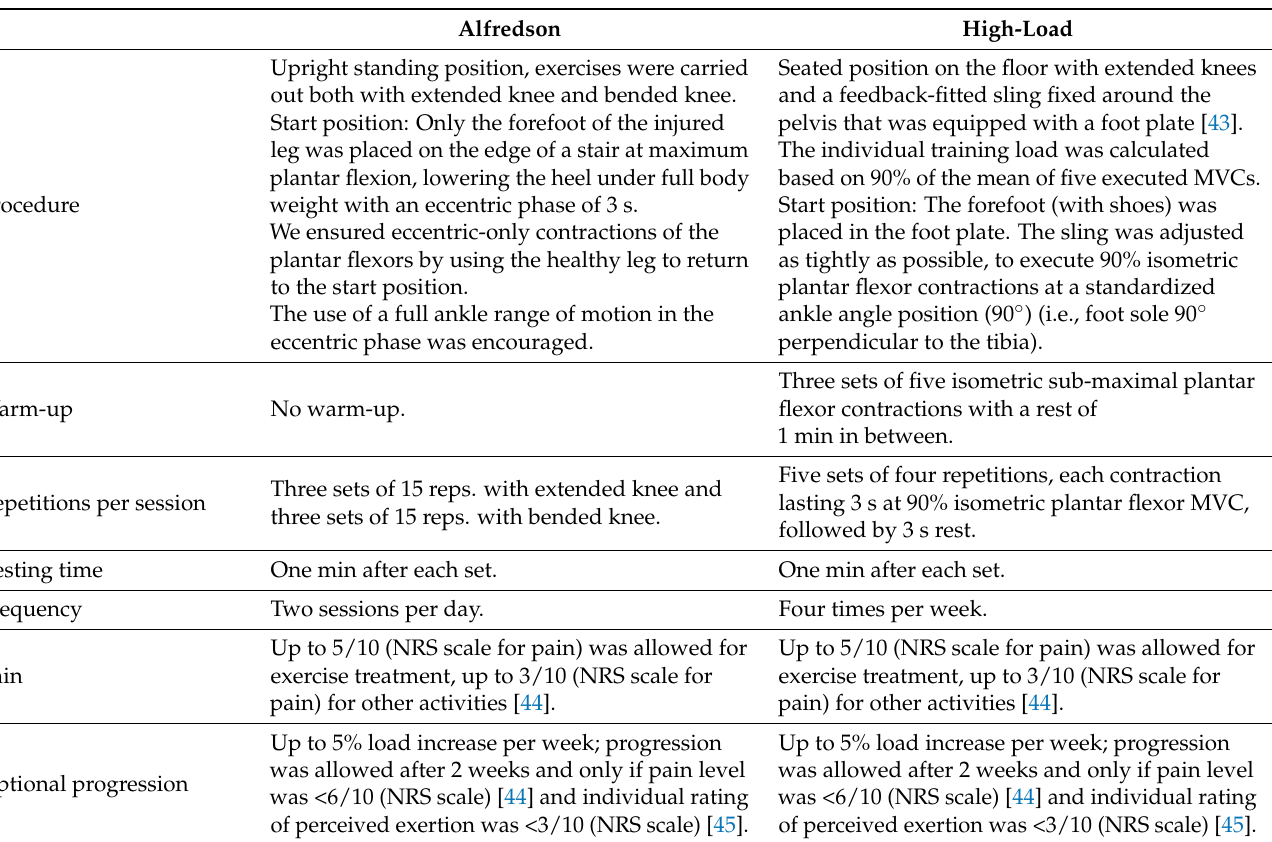
Table 2. Characteristics of both therapeutic interventions: Eccentric exercises (i.e., the Alfredson protocol) and high-loading